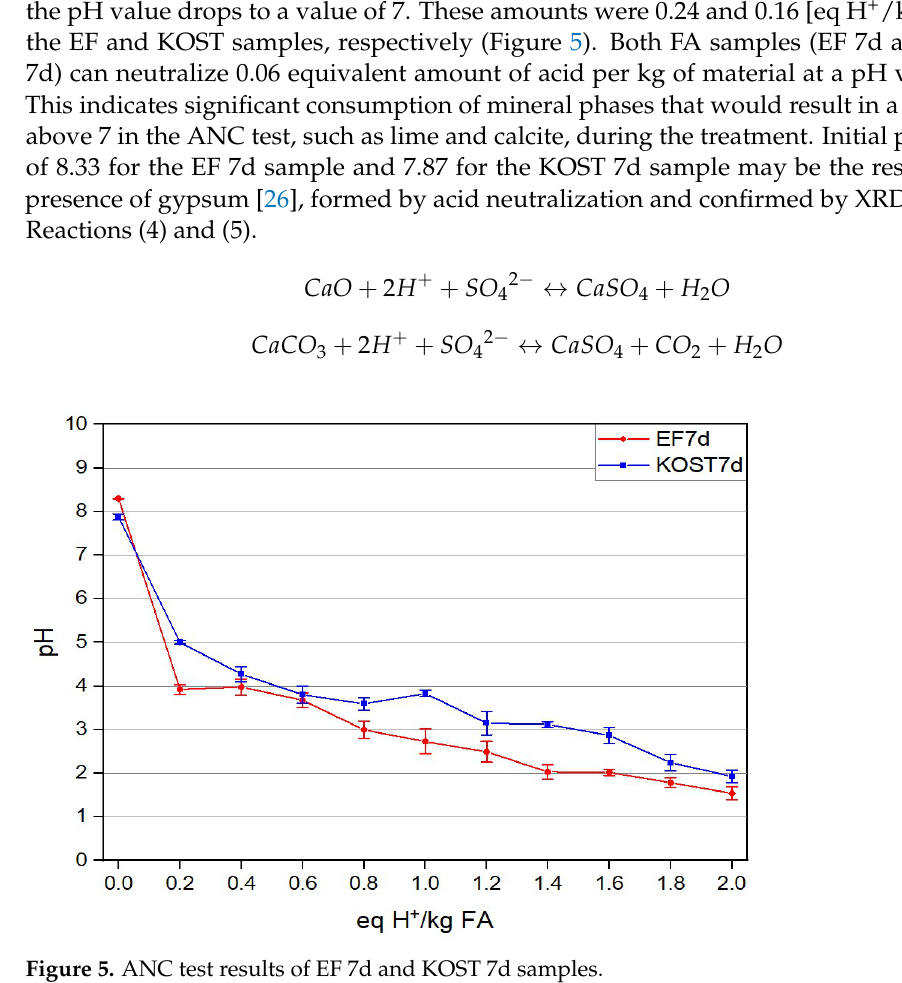
Figure 4. XRD analysis of EF7d and KOST7d fly ash samples.